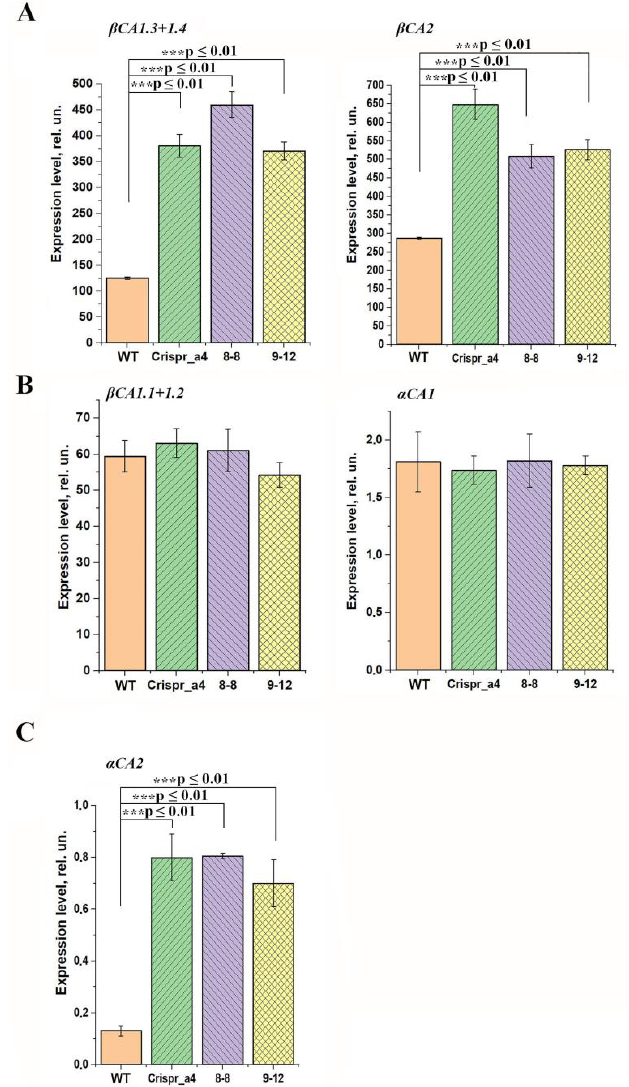
Figure 5. The expression level of the genes encoding cytoplasmic CAs ( A ): β CA1.3 + β CA1.4 and β CA2 ; stromal CAs; ( B ): β CA1.1 + β CA1.2 and α CA1 ; ( C ) thylakoid α CA2 in Arabidopsis WT plants and α CA4-KO lines: Crispr_ α 4, 8-8 and 9-12. Data were normalized for actin gene expression. Values are means ± S.E (n = 3) of three independent experiments. Significant differences were denoted as *** p ≤